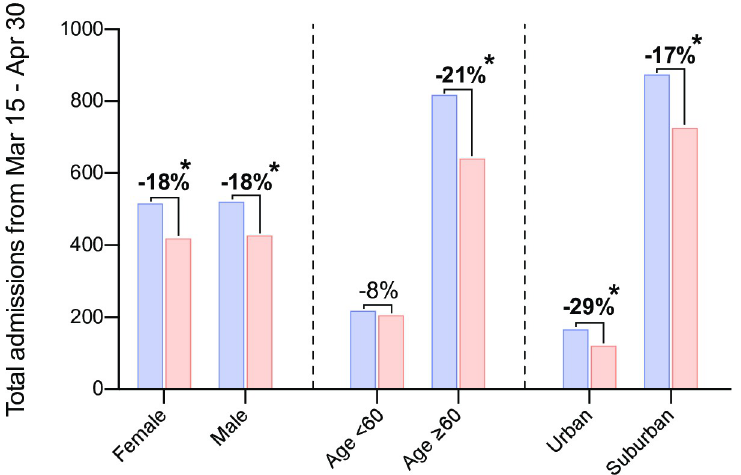
Fig 3. Analysis of total admissions according to patient characteristics during the lock-down period. Numbers were collected from March 15 to April 30 from 2019 and 2020. Bold label and asterisk indicate a significant difference between 2020 and 2019 in the Poisson Model. (2020 vs. 2019 for female p = 0.006, male p = 0.003, age � 60 p < 0.001, suburban p = 0.001, urban p = 0.015).